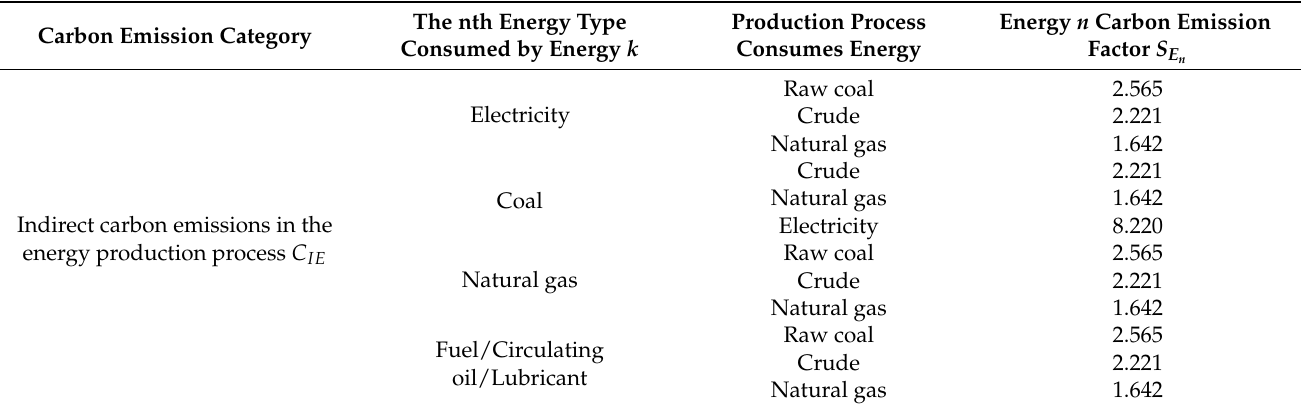
Table 5. Values of indirect carbon emission factors in the energy preparation process from en- ergy consumption.